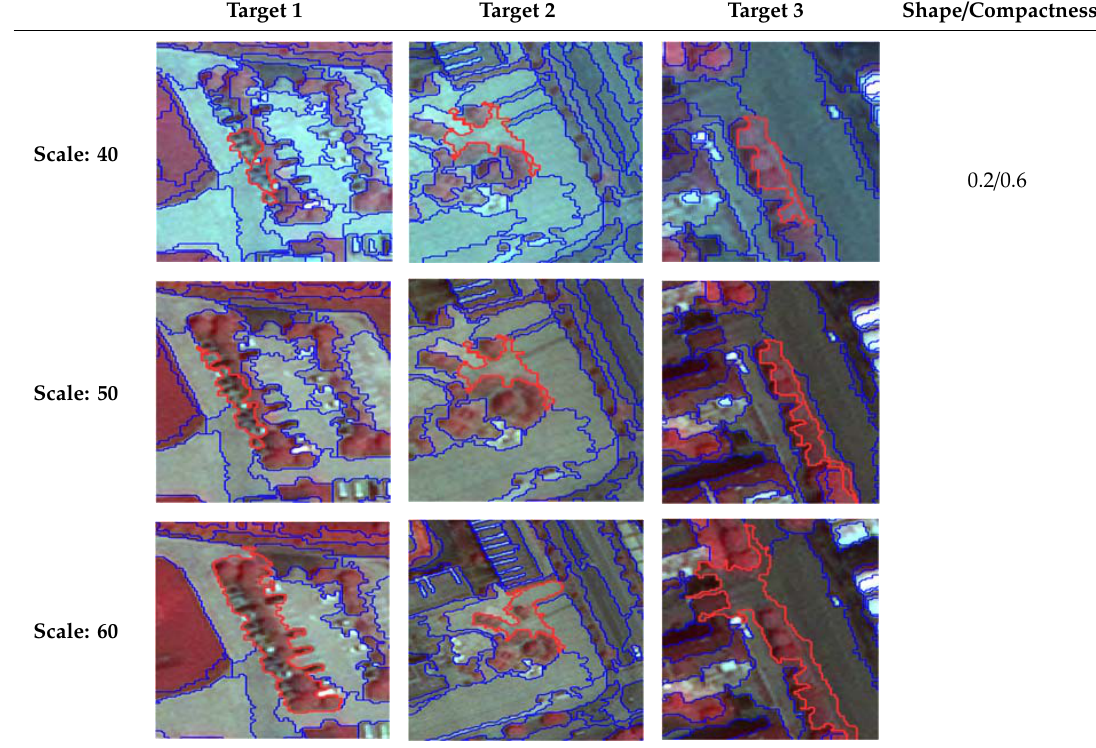
Figure 3. Scale parameters obtained by ESP (estimation of scale parameter). Table 3. Comparison of segmentation scale effects (based on ESP).